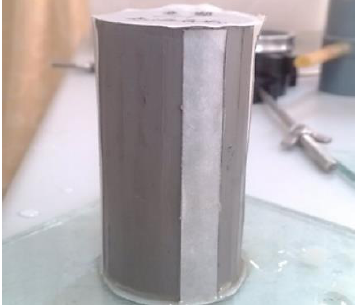
Figure 1. The remolded soil sample.